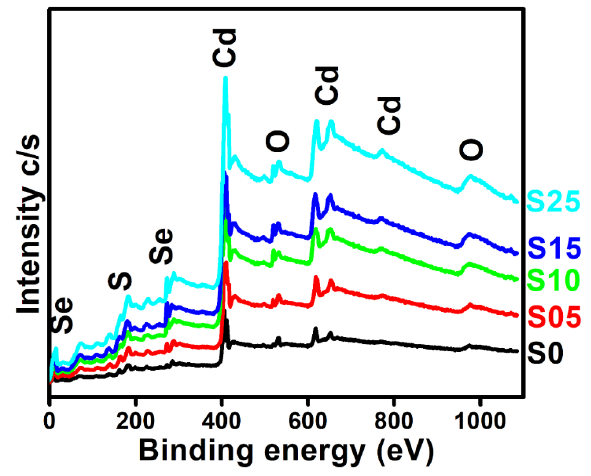
Figure 5. XPS survey spectra for binary CdSe and ternary CdSSe with different contents of sulfur.